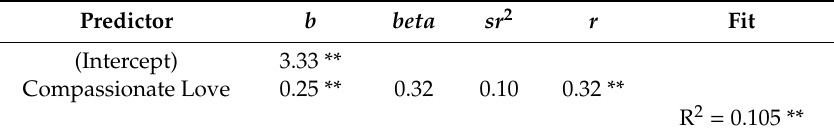
Table 3. Regression results for compassionate love using servant leadership as